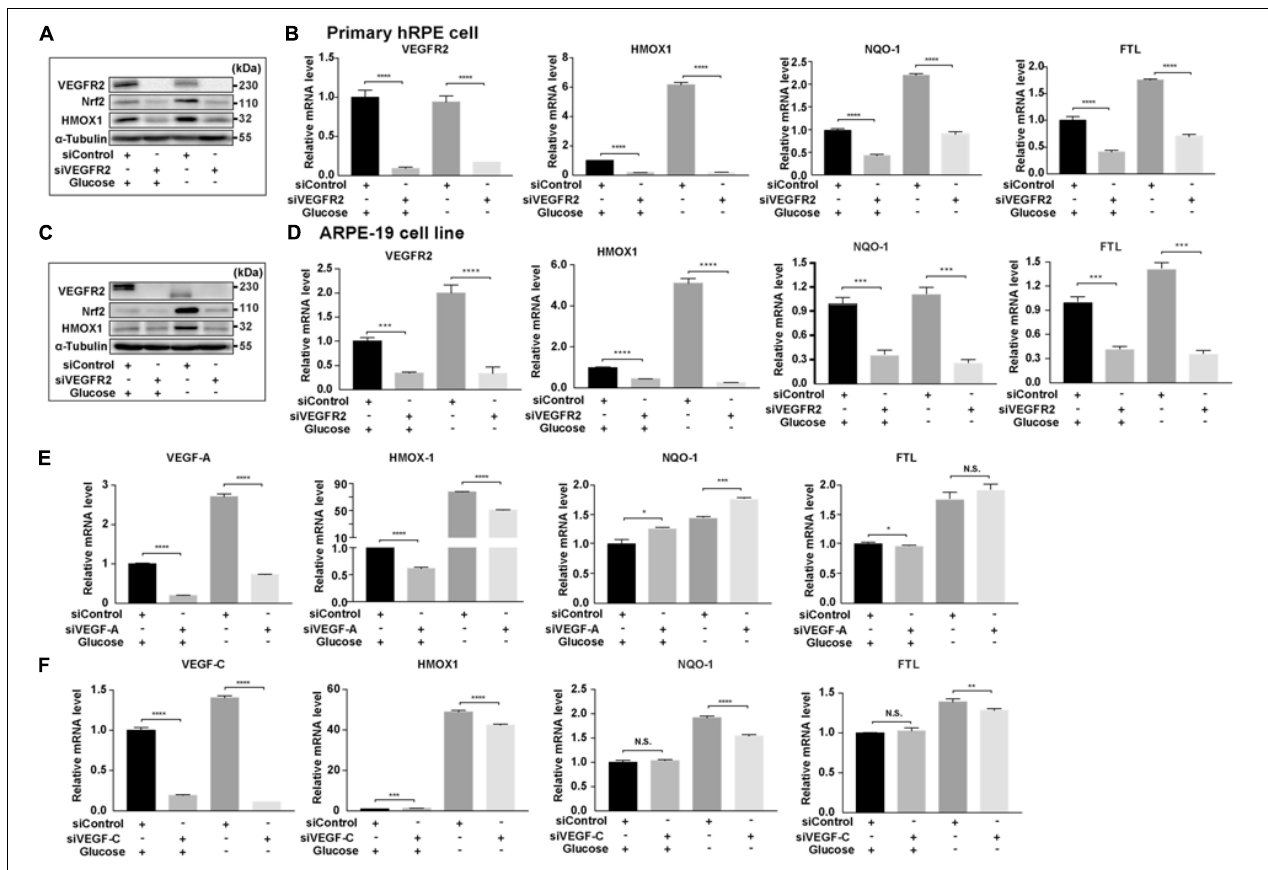
FIGURE 6 | Depletion of VEGFR2 alleviated Nrf2 signaling pathway. (A) VEGFR2 knockdown via siRNA reduced glucose-deprivation-mediated Nrf2 protein accumulation and its downstream target HMOX-1 in primary hRPE cells. (B) VEGFR2 siRNA knockdown decreased the expression of Nrf2 downstream targets in primary hRPE cells. (C) VEGFR2 siRNA knockdown decreased Nrf2 and HMOX-1 protein accumulation in ARPE-19 cells. (D) VEGFR2 siRNA knockdown decreased the expression of Nrf2 downstream targets in ARPE-19 cells. (E) VEGF-A siRNA knockdown was unable to reduce glucose-deprivation-mediated gene expression of Nrf2 downstream targets. (F) VEGF-C siRNA knockdown was unable to reduce glucose-deprivation-mediated gene expression of Nrf2 downstream targets. All error bars indicate S.D. * P < 0.05, ** P < 0.01, *** P < 0.001, **** P <